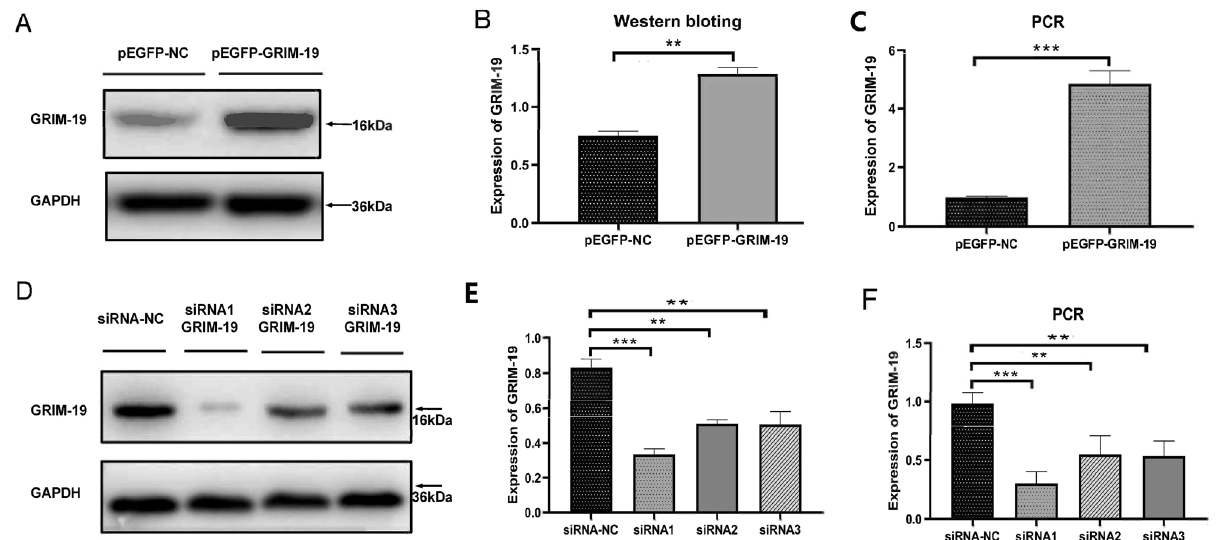
Figure 3. Expressions of GRIM-19 in GC-2 spd cell with overexpressed and silenced GRIM-19. ( A ) Western blotting analysis of protein expressions of GRIM-19 in pEGFP-NC and pEGFP-GRIM-19 cells; ( B ) Gray value analysis of western blotting results (pEGFP-NC vs pEGFP-GRIM-19); ( C ) RT-QPCR analysis of mRNA expression of GRIM-19 in pEGFP-NC and pEGFP-GRIM-19 cells; ( D ) Western blotting quantitative analysis of total protein expressions of GRIM-19 in siRNA-NC, siRNA1-GRIM-19, siRNA2-GRIM-19 and siRNA3- GRIM-19 cells; ( E ) Gray value analysis of western blotting results (siRNA-NC vs siRNA1-GRIM-19, siRNA2- GRIM-19, siRNA3-GRIM-19). ( F ) RT-QPCR analysis of mRNA expression of GRIM-19 in siRNA-NC, siRNA1- GRIM-19, siRNA2-GRIM-19 and siRNA3-GRIM-19 cells. ** represents p < 0.01, *** represents p < 0.001, NC represents Natural control.